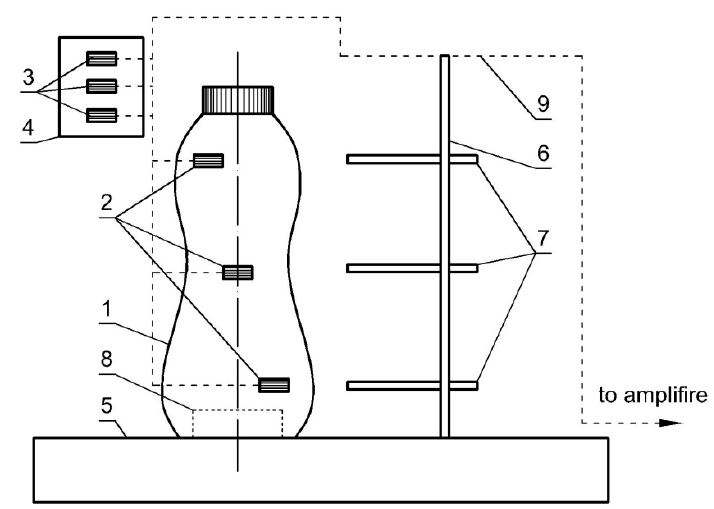
Figure 4. Schematic representation of a container with the attached strain gauges on a stand: 1—container, 2—strain gauges, 3—compensating strain gauges, 4—unloaded material, 5—base, 6—mandrel, 7—thermocouples, 8—magnet, 9—wiring.